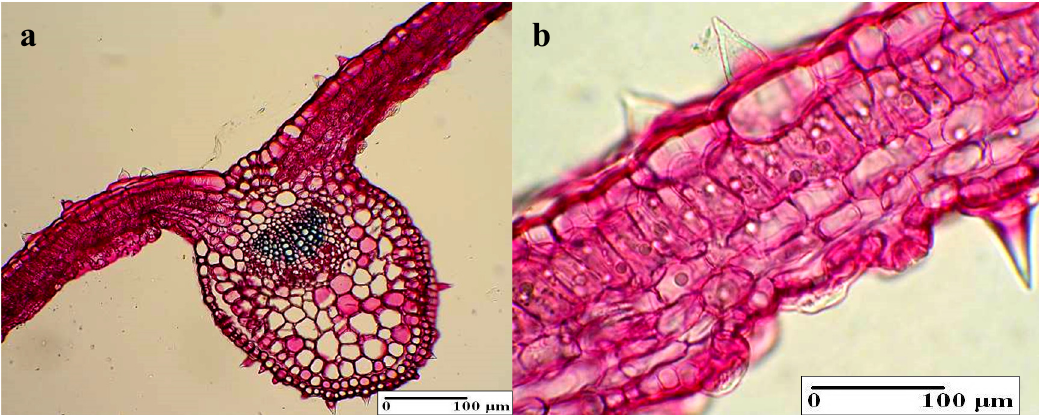
Figure 6. The internal structure of the leaf: ( a ) general aspect (control), ( b ) mesophyl with secretory hairs (control).